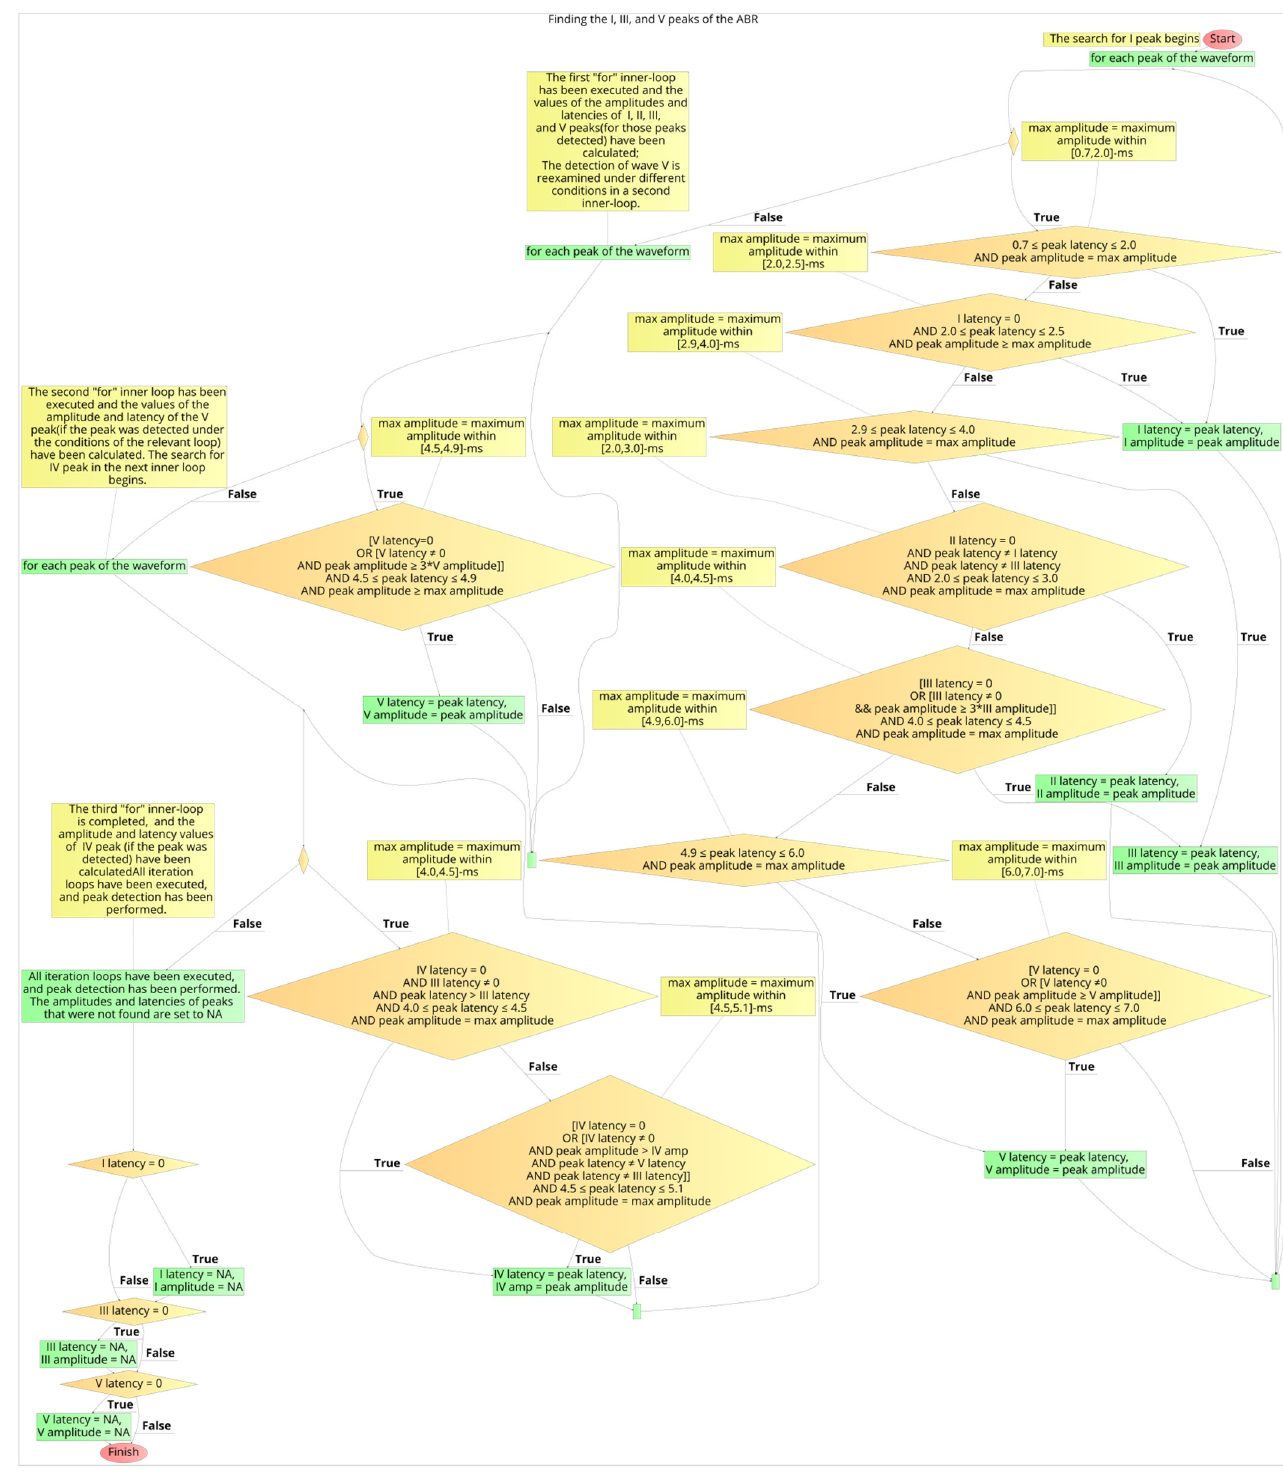
Figure 12. The flowchart of the automated waves detection algorithm for an ABR waveform.